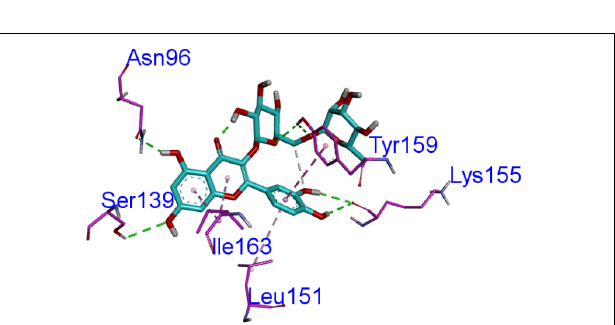
FIGURE 7 | The ligand of rutin compared by the LibDock docking method. The atoms of the compound, rutin, are shown in ball-and-stick format and colored by atom. Polar interactions are shown as dashed colored lines. Among them, the green dotted line represents the hydrogen bond interaction. The pink dotted line represents p- π interactions